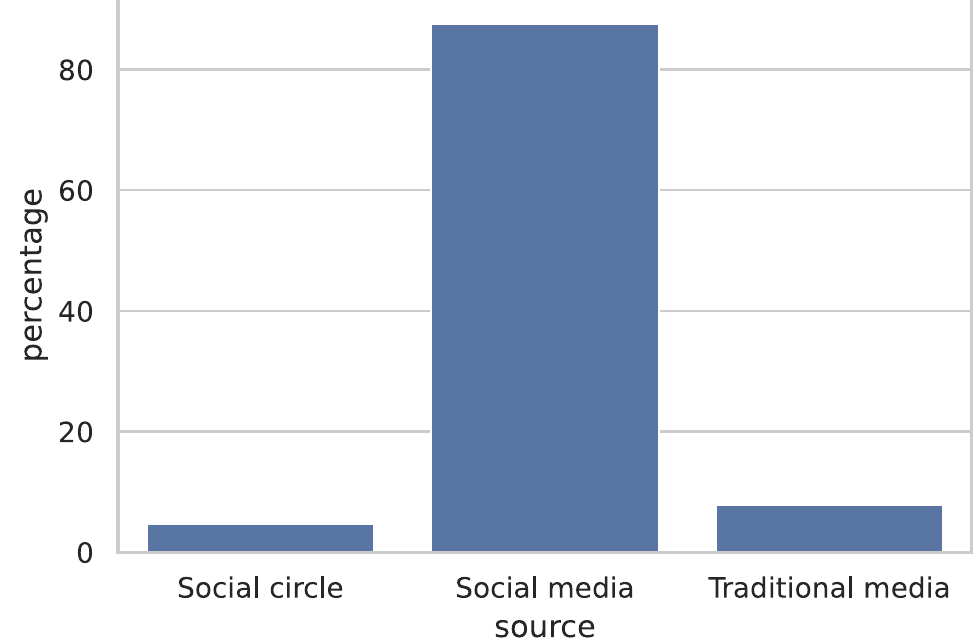
Figure 4. Reported Sources of Misinformation by the